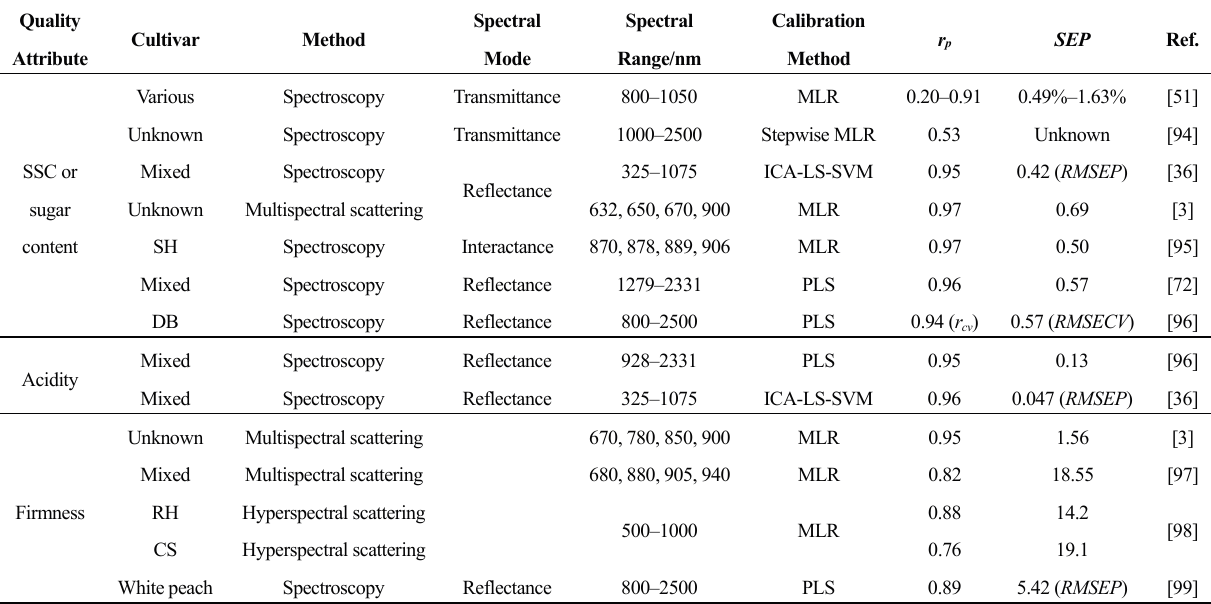
Table 5. Overview of applications for measuring quality attributes in